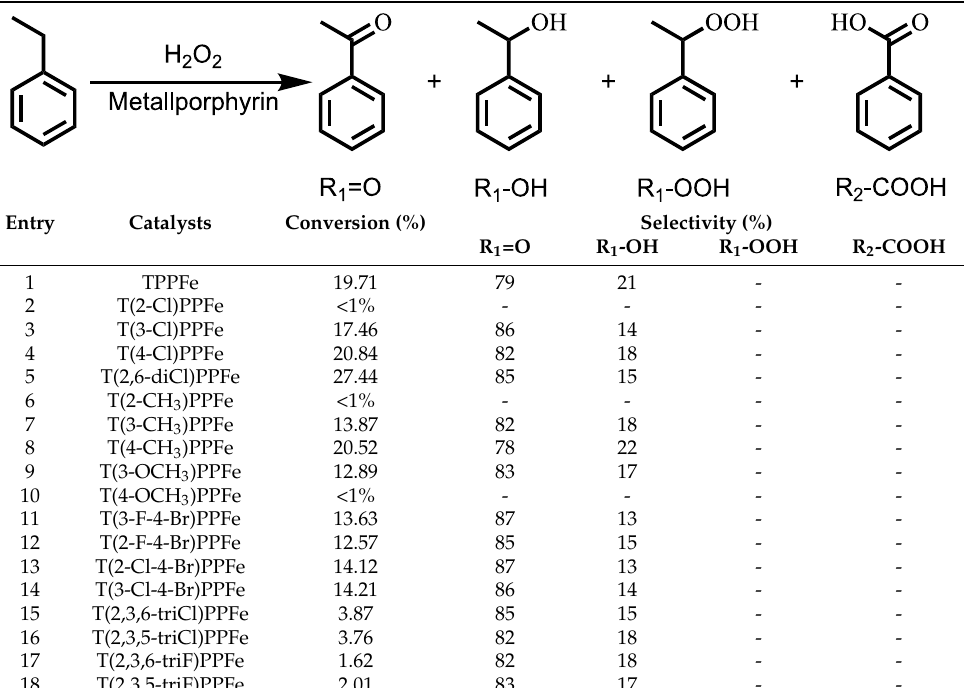
Table 3. Effect of porphyrin structures on oxygenation of alkyl aromatics employing ethylbenzene as model substrate a .